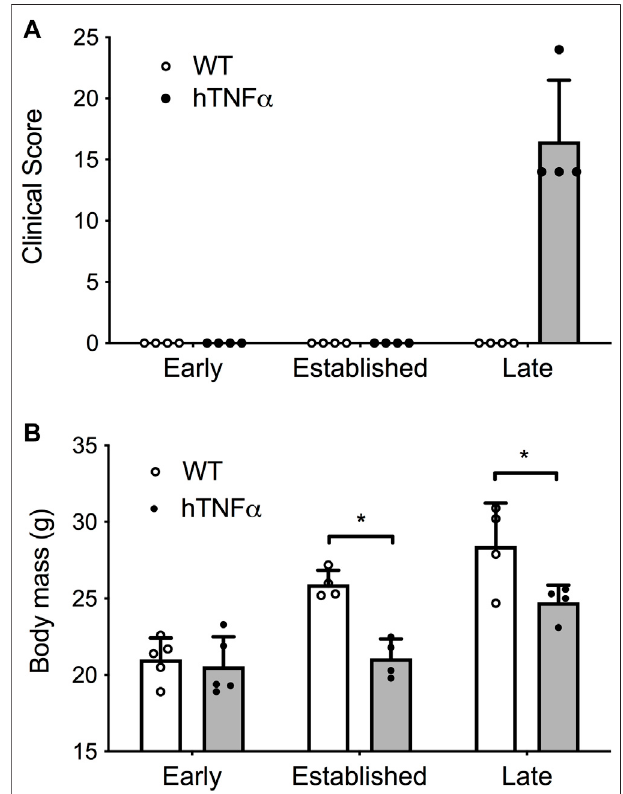
FIGURE1| ProgressionofarthritisinhTNF- α transgenicmice.Wild-type and hTNF- α mice were studied at three stages of disease: early (8 weeks), established (12 weeks), and late (19 weeks). (A) Mean clinical score based on total paw swelling ±standard deviation. (B) Mean body mass (g) ± standard deviation. Unpaired t -test, * p <